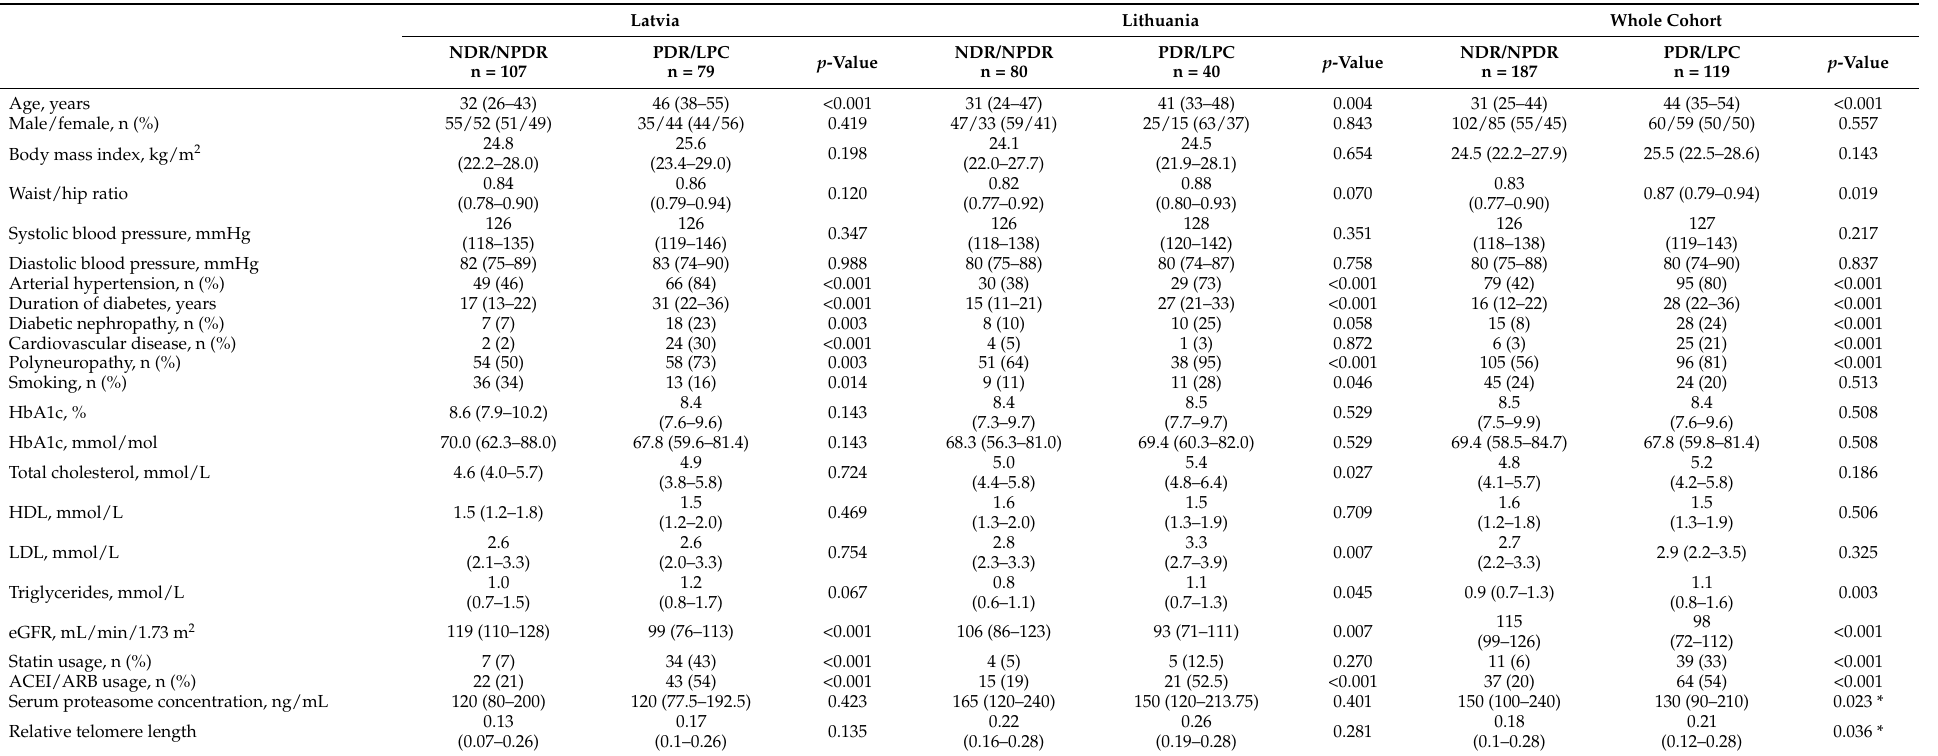
Table 2. Characteristics of patients stratified according to retinopathy status in Latvia, Lithuania, and the whole